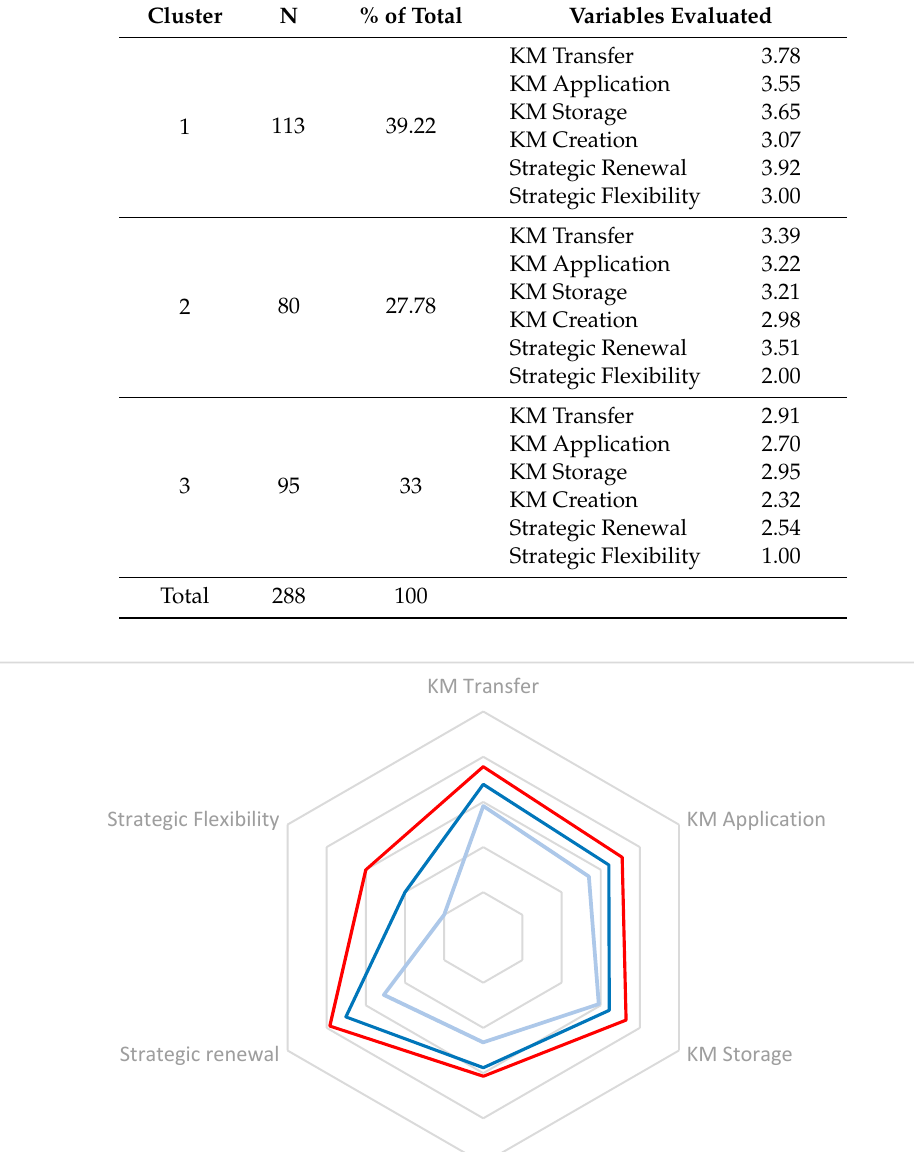
Table 3. Two-step clustering analysis results.